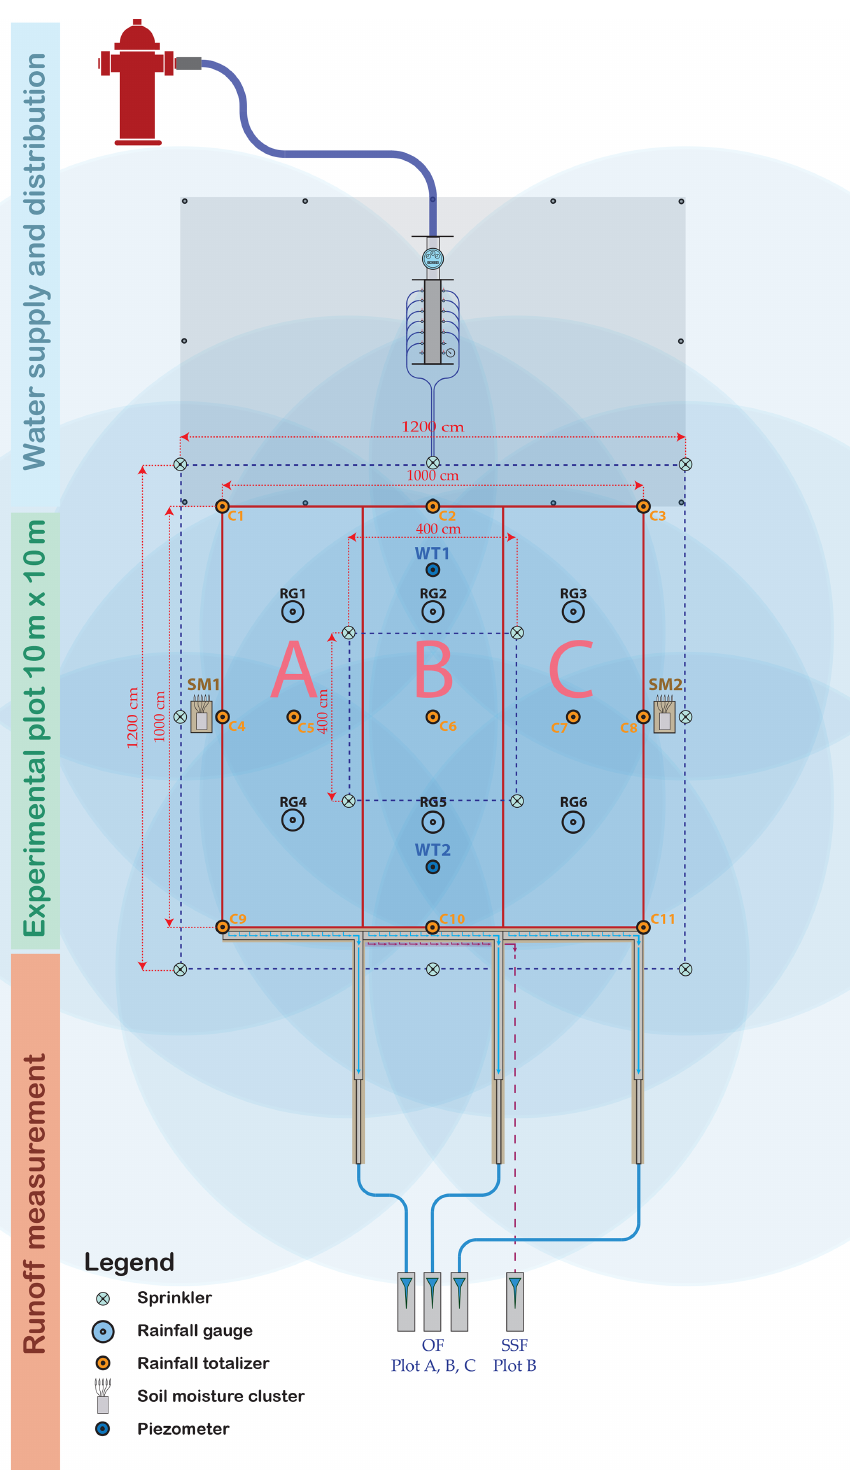
Figure 2. Illustration of the experimental setup with water supply and distribution, experimental plot, and devices for the quantification of overland flow and subsurface runoff. Runoff was measured from an area of 10m × 10m, while the irrigated area covered approximately 15m × 15m to reduce boundary effects. The blue shaded circles illustrate the approximate extent of each sprinkler.